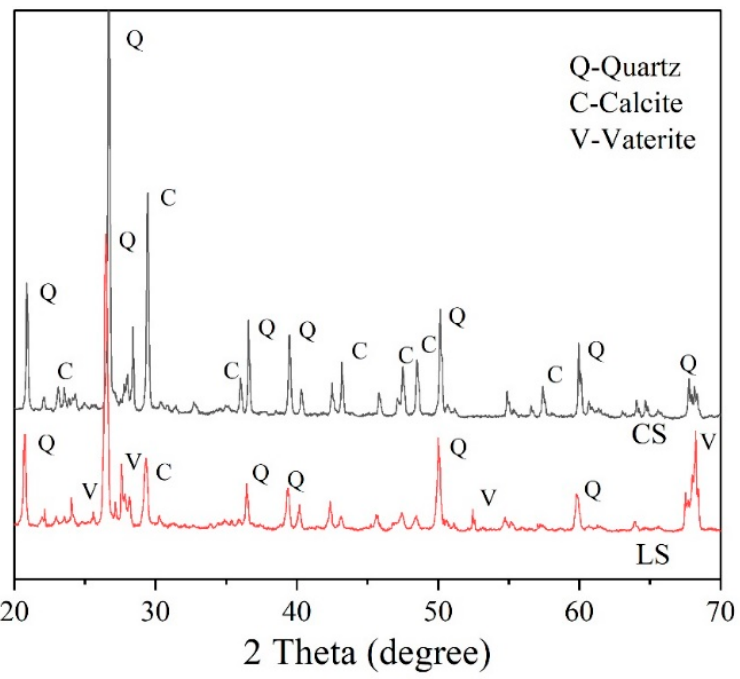
Figure 6. XRD patterns of sand samples treated with different calcium sources (CS: calcium chloride sample, LS: Limestone sample).